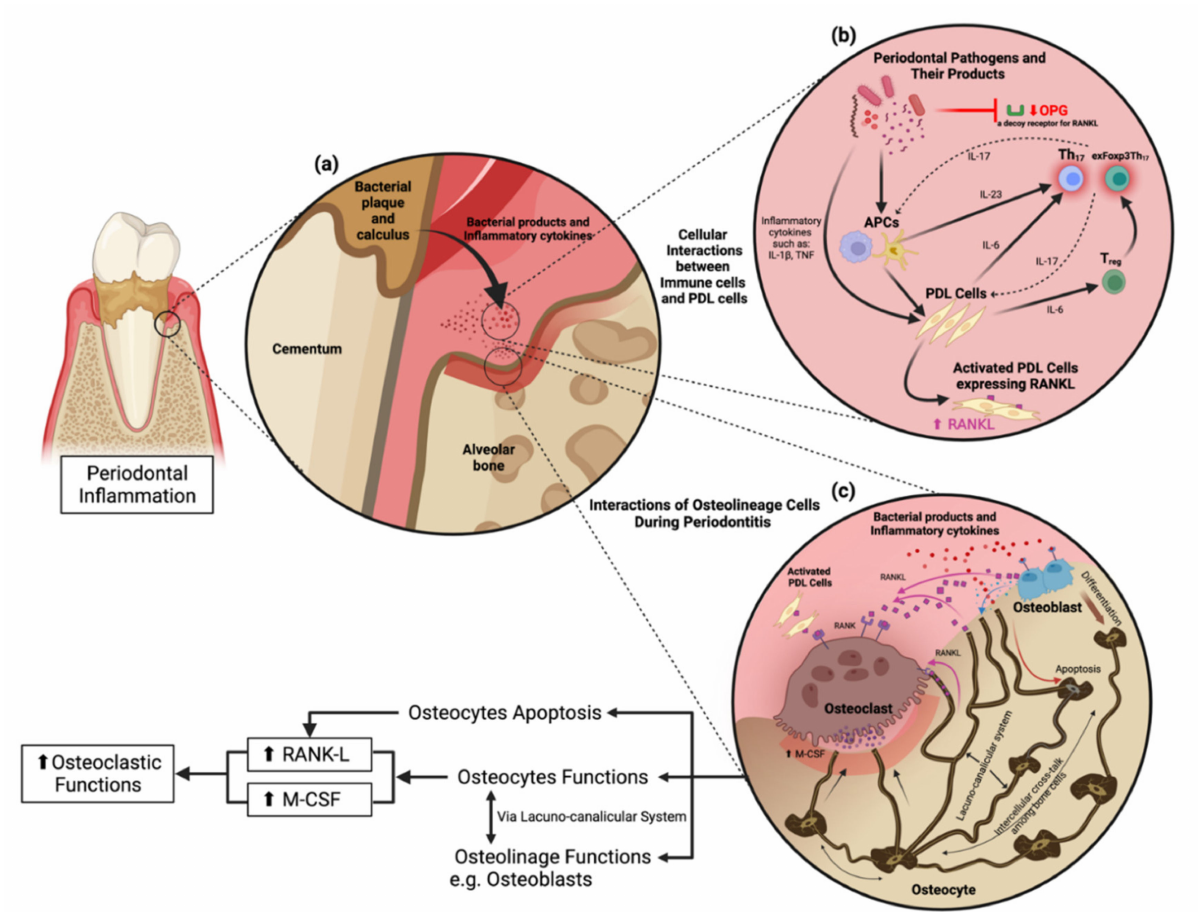
Figure 1. Cellular interactions and osteocyte function in periodontitis. ( a ) Pathogenic bacteria in the periodontal pocket release their virulence factors to stimulate proinflammatory cytokine production from periodontal stromal cells and immune cells in the periodontium. ( b ) Cellular interactions in response to periodontitis. Periodontal pathogens and their products activate antigen-presenting cells (APCs) in the periodontium to stimulate periodontal ligament cells (PDL cells) following the activation of Th17 and exFoxp3Th17 cells. ( c ) Osteocyte functions and their interactions with other cells through the lacunocanalicular system